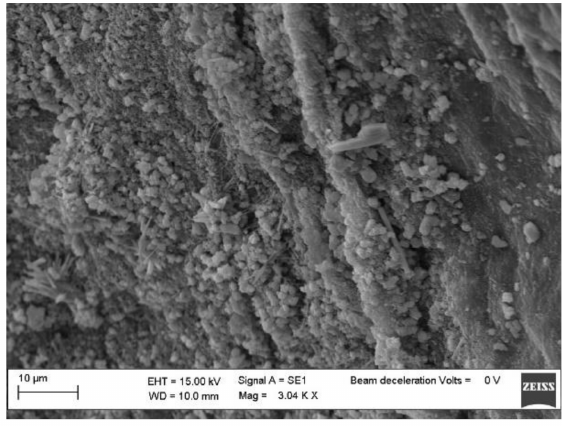
Figure 5. SEM micrograph of the BC surface.